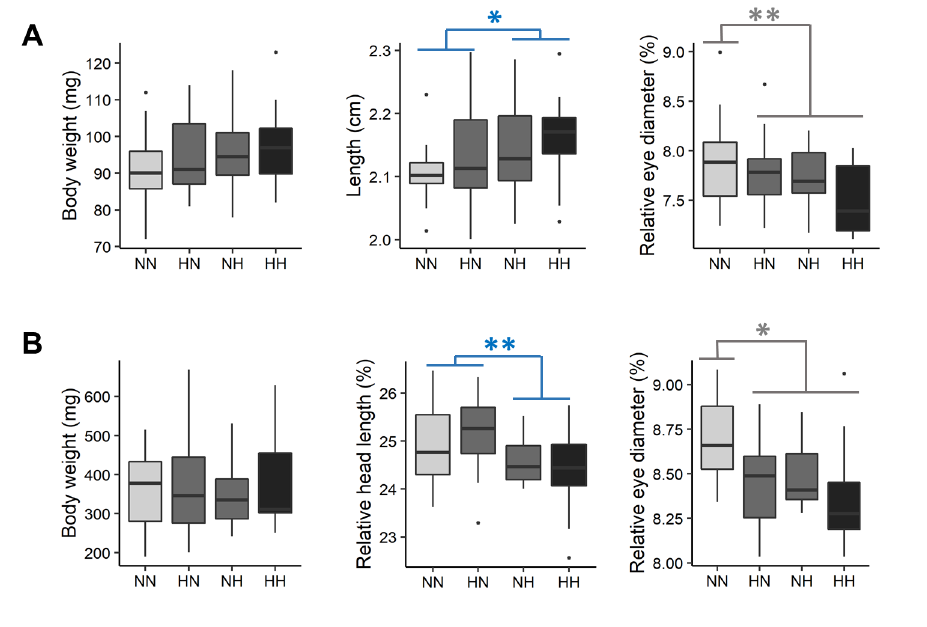
Figure 2. Effect of the parental HC/LP on fry body mass, length, relative head length, and relative eye diameter ( A ) before first feeding and ( B ) after 3 weeks of feeding. The effect of the paternal nutritional history is depicted in blue and the effect of both the maternal and the paternal nutritional history in grey (”**” means p -value < 0.01 and ”*” means p -value < 0.05). After 3 weeks of feeding, fry weighed 362.41 ± 106.75 mg (Figure 2B). No significant differences were detected in fry body morphologies (i.e., for BW, K, L and D). However, the head proportions of NH and HH fry were on average 2.44% lower than those of HN and NN fry ( χ 2 = 10.7, df = 1, p = 0.001). Moreover, the eye proportions of HN, NH,